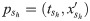
(a) Logistic curve and its symmetric curve for two salient points, psh=(tsh,xsh′) and psh+1=(tsh+1,xsh+1′), and (b) four different curves that are used to rebuild a stream segment depending on the values of μratio and (xsh′-xsh+1′).